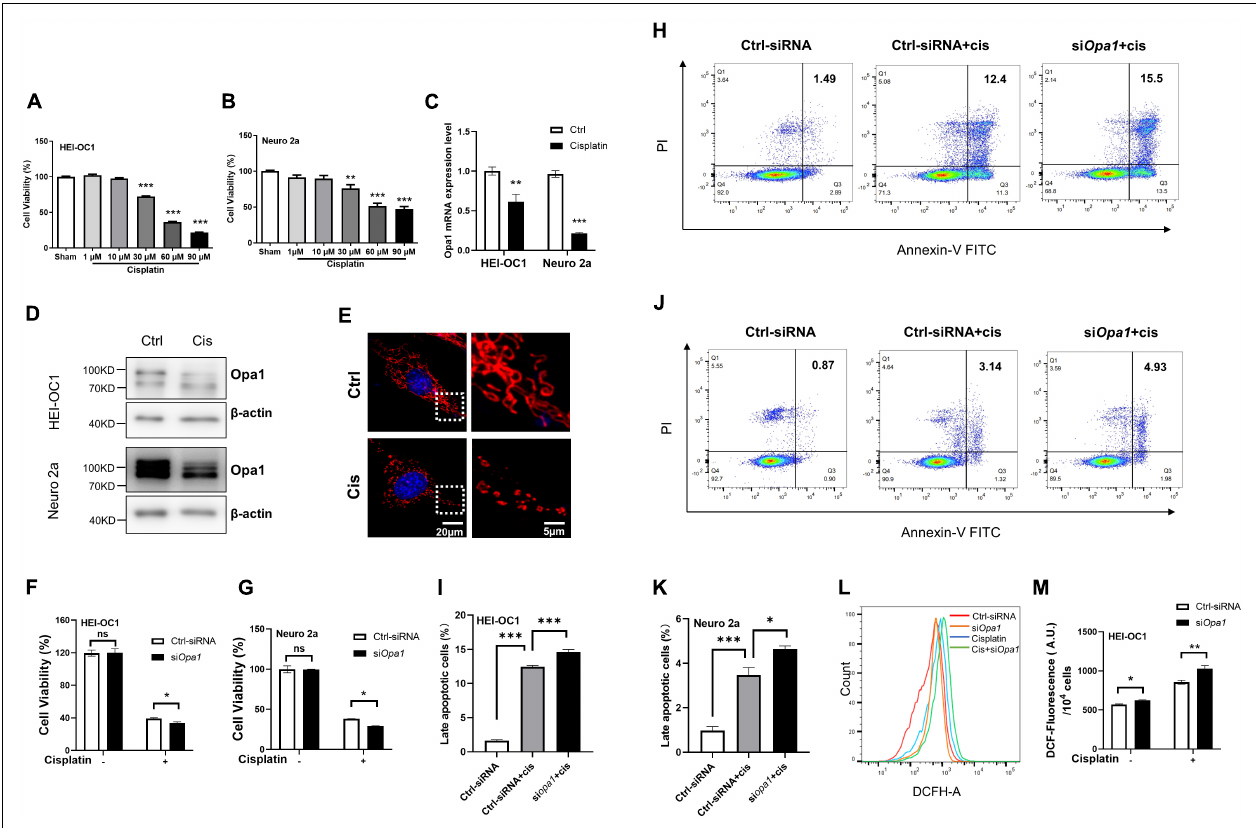
FIGURE 4 | Knockdown of Opa1 aggravates cisplatin-induced apoptosis and mitochondrial dysfunction in HEI-OC1 and Neuro 2a cells (A,B) CCK-8 was used to assess cell viability in HEI-OC1 (A) and Neuro 2a (B) cells treated with the indicated doses of cisplatin for 24 h. ** p < 0.01, *** p < 0.001 (one-way ANOVA with Dunnett’s multiple comparisons test). (C) Quantification of Opa1 mRNA expression levels in HEI-OC1 and Neuro 2a cells treated with cisplatin for 24 h. ** p < 0.01, *** p < 0.001 (two-way ANOVA). (D) Representative Western blot images of Opa1 expression in HEI-OC1 and Neuro 2a cells treated with cisplatin for 24 h. (E) Representative confocal microscopic images of MitoTracker staining at 24 h after cisplatin treatment of HEI-OC1 cells. Right panels show magnified views of the areas marked in the left panels. (F,G) CCK-8 was used to assess cell viability in HEI-OC1 (F) and Neuro 2a (G) cells at 24 h after siRNA transfection with or